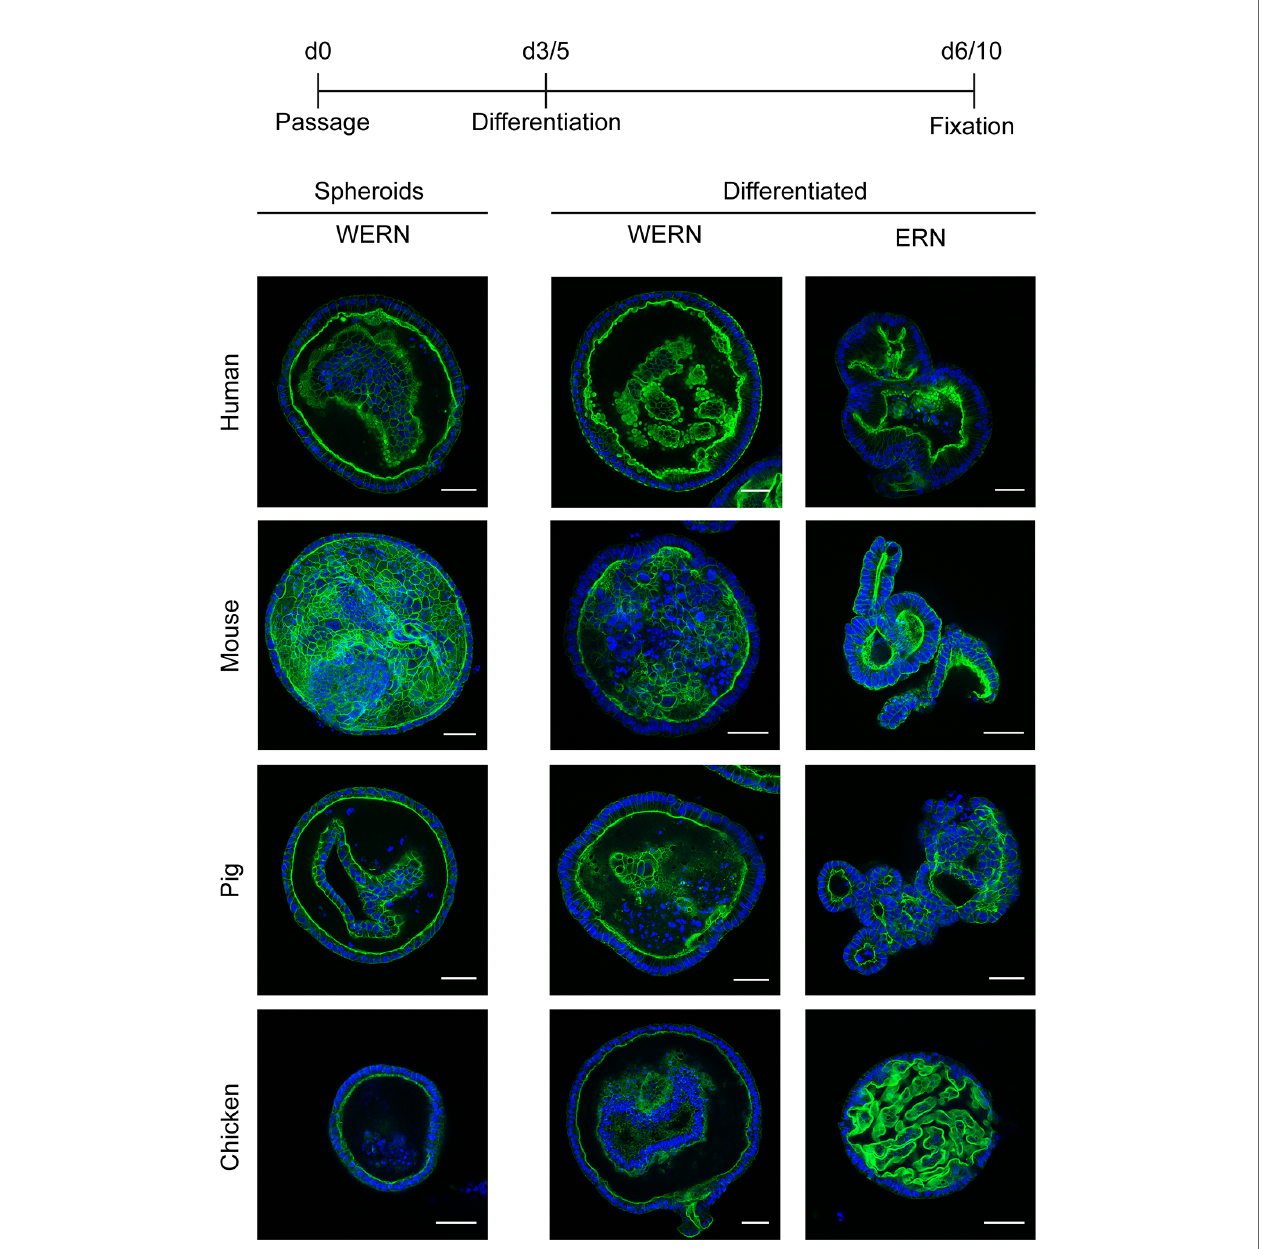
FIGURE 2 | Fluorescence analysis of brush border localization in 3D spheroids/organoids from human, mouse, pig and chicken origin. A new spheroid passage was cultured for 3 days (5 days for human) in WERN medium and then spheroids were either maintained in WERN medium or differentiated in ERN medium for further 3 days (human for 5 days). As a control, 3/5 day spheroids in WERN were also assessed in parallel. Subsequently spheroids/organoids were fi xed and F-actin in the microvilli of the luminal brush border was visualized by staining with Phalloidin iFluor-488 (green). Cell nuclei were stained with DAPI (blue). Note, video composition of z-stacks are also provided as Supplementary Material . Scale bars represent 50 µm. All experiments were performed twice with similar